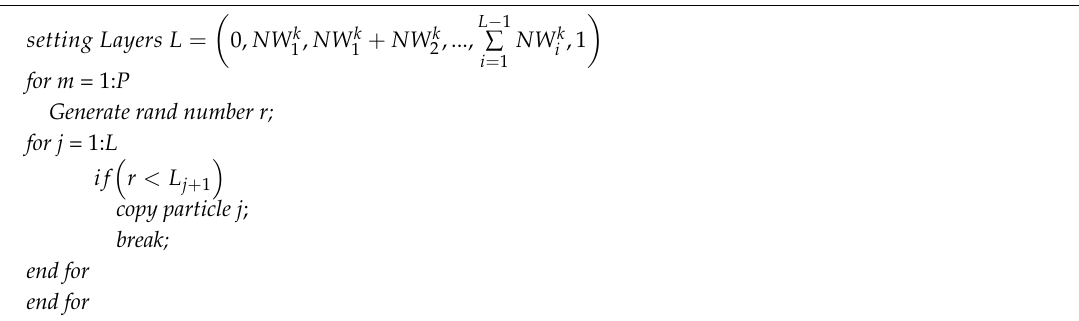
Algorithm 4. Particle copy.